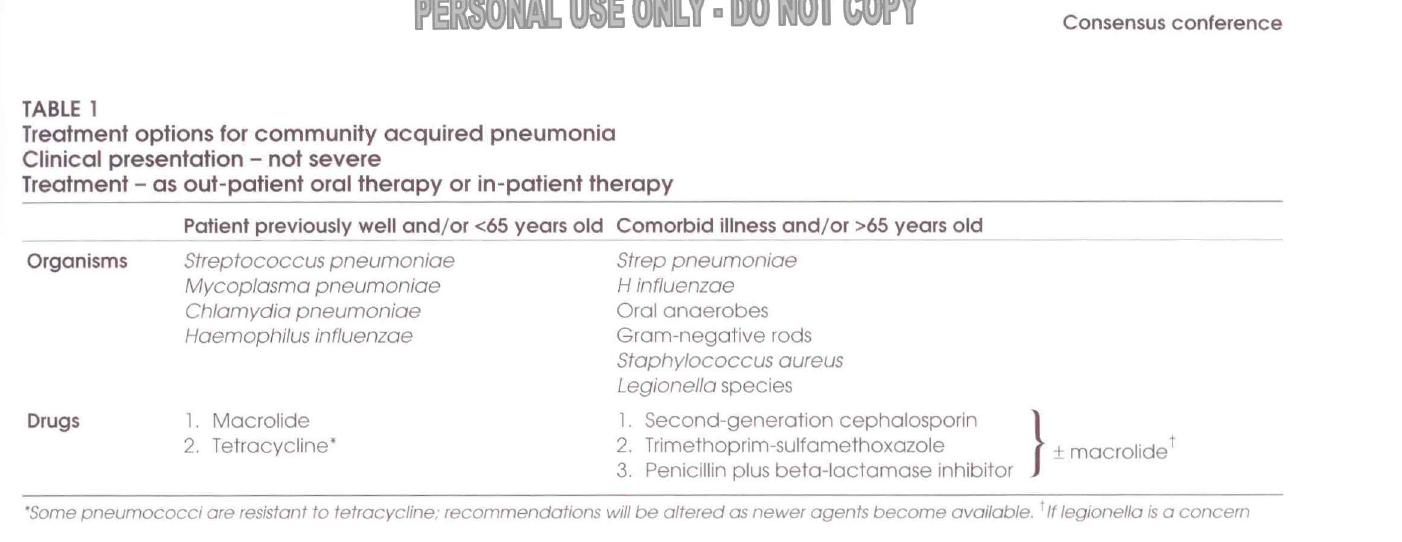
TABLE 2 Treatment options for community acquired